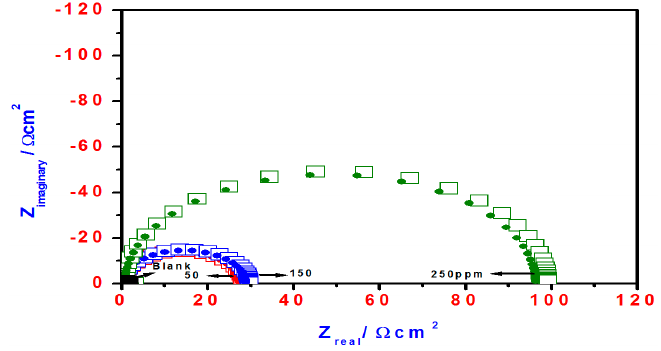
Figure 5. The influence of T3Q concentrations on the the Nyquist plots of steel in acidic chloride solution.